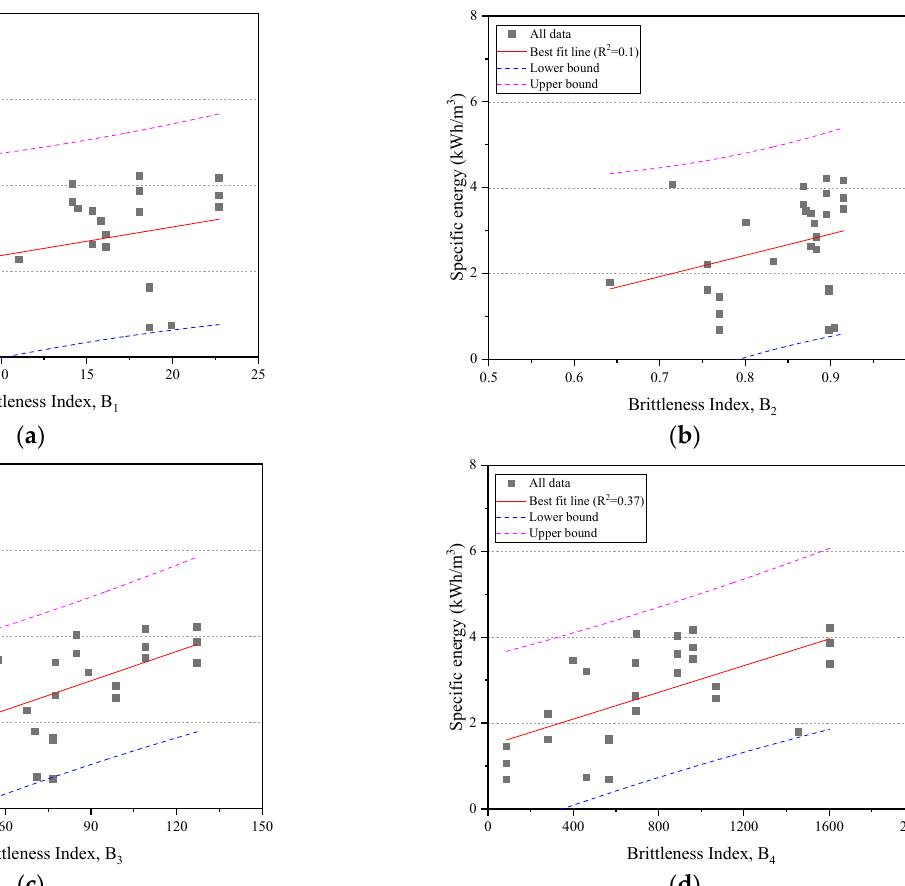
Figure 8. Relationship between specific energy and brittleness indices: ( a ) SE–B 1 ; ( b ) SE–B 2 ; ( c ) SE–B 3 ; ( d ) SE–B 4 .